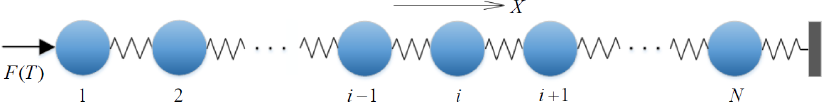
Figure 1. Elastic mass–spring chain.